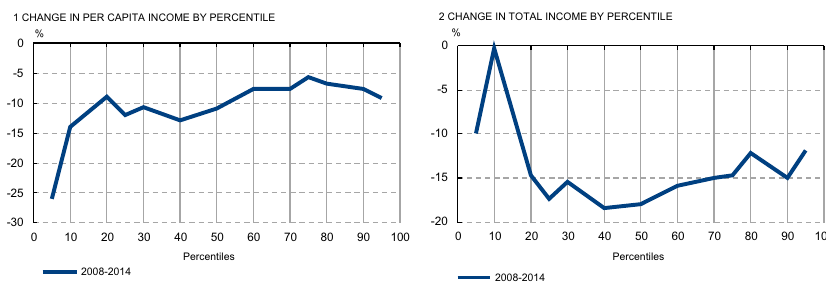
Fig. 10 Changes in per capita and total income. Source : Banco de España